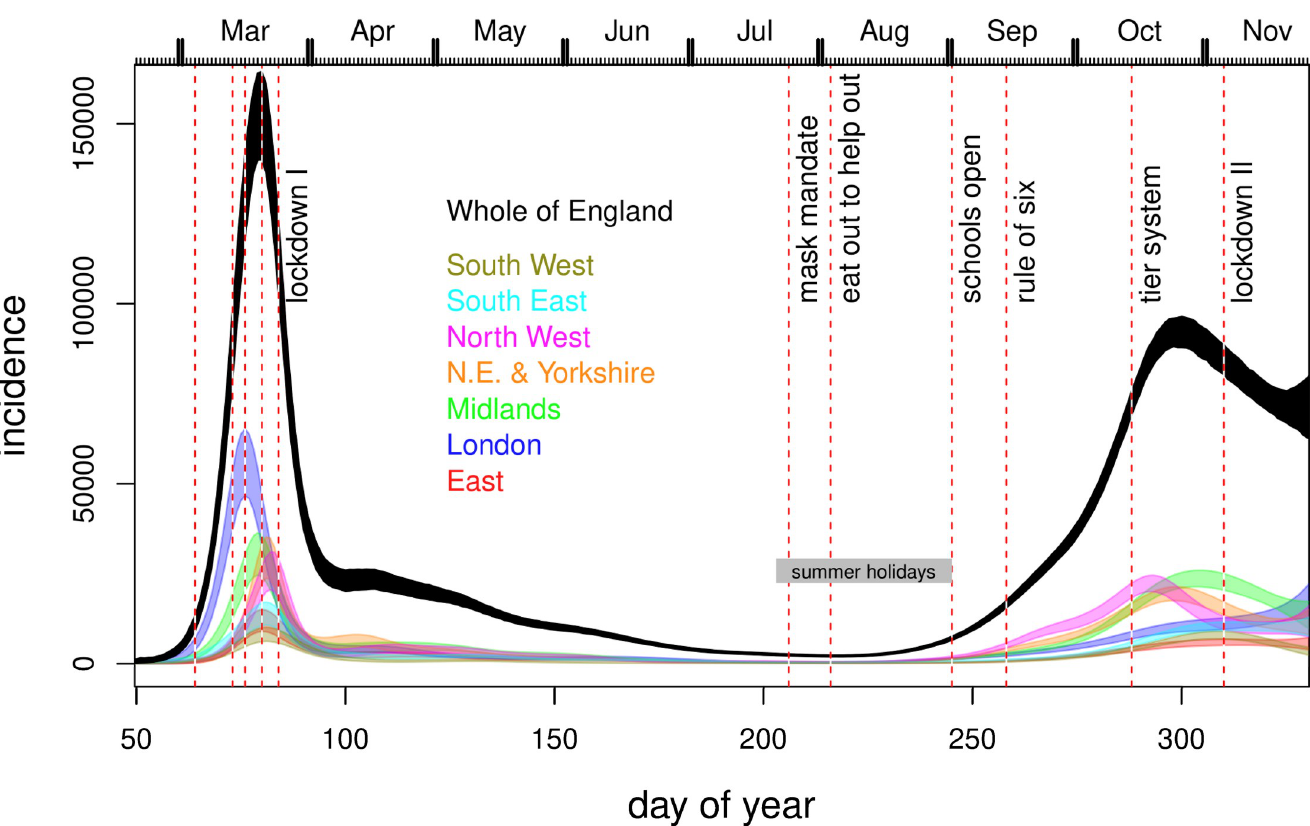
Fig 4. Inferred incidence, for all regions (coloured) and whole of England (black). Notional 95% credible bands are shown. These do not reflect all the uncertainty in rate parameters and assume a correct model structure: hence they provide a lower bound on uncertainty. Vertical dashed lines show some policy changes. The 4 preceding lockdown I are information campaign, symptomatic self isolation, work from home advice, school and hospitality closures. ‘Eat out to help out’ was a scheme encouraging people to use the restaurants and pubs. The re-opening of schools after the first lockdown is also shown. Subsequent policies introduce increasing levels of